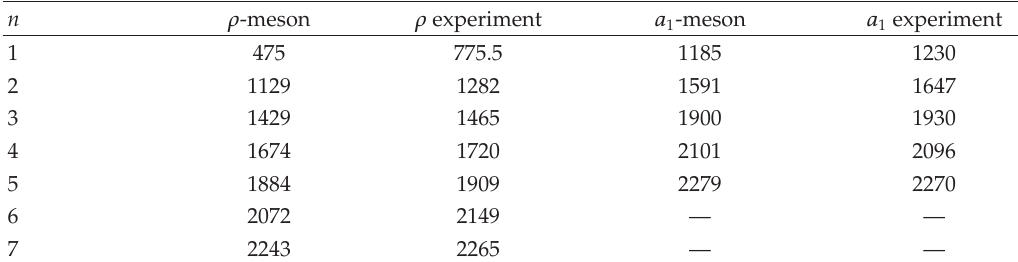
Table 2: Meson spectroscopy from the modified soft wall model (cid:4) 69 (cid:5) . We show the center values of experimental data. In (cid:4) 69 (cid:5) the experimental data are mostly taken from the particle data group (cid:4) 62 (cid:5) , while ρ (cid:2) 1282 (cid:3) is from (cid:4) 76 (cid:5) . All results are given in units of MeV. n ρ -meson ρ experiment a 1 -meson